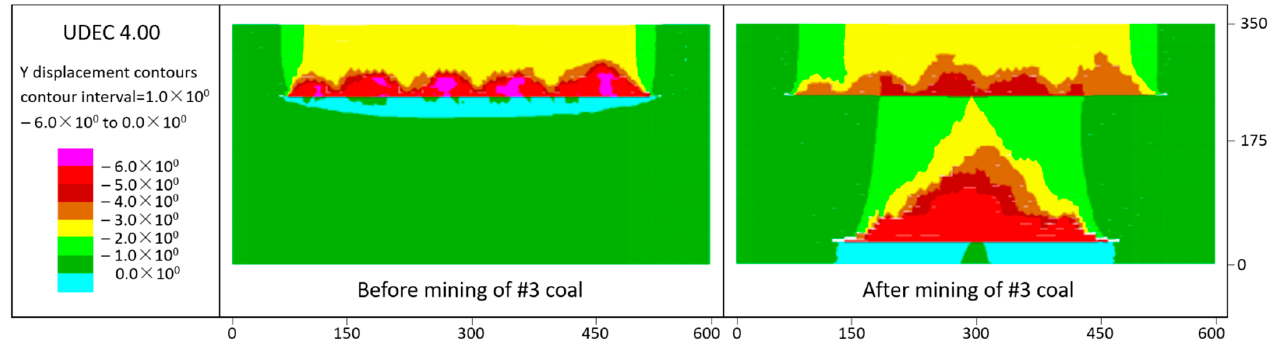
Figure 8. Comparison diagram of displacement distribution of overlying rock before and after mining of # 3